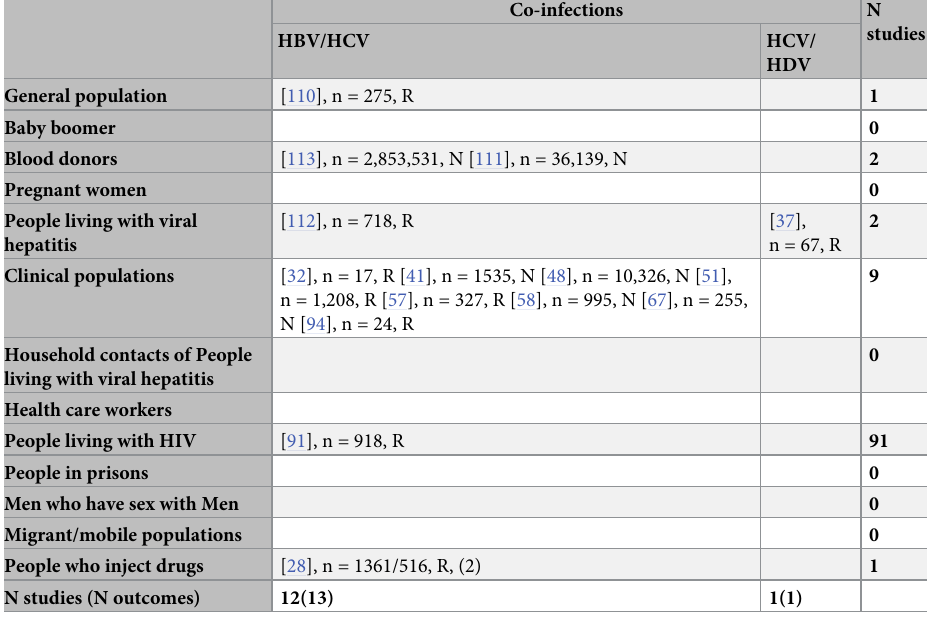
Table 5. Matrix for publications on HBV/HCV and HCV/HDV co-infections (publications by population and out- come category). Shown are name_year of publication, sample size, place of data collection (local/regional (R) = one or more than one city in one region, nationwide (N) = more than one city allover the